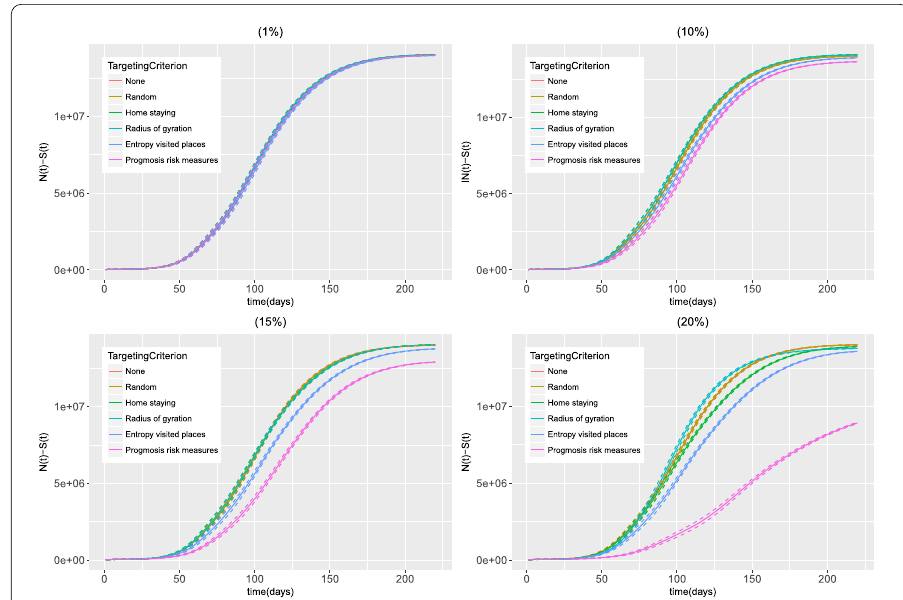
Figure 4 Performance of individual-level isolation based on different spatial indexes for determining targeted individuals ( none : no counter measure, random : a portion of individuals isolated randomly, radiusofgyration : a portion of individuals isolated based on the value of their radius of gyration, entropyvisitedplaces: a portion of individuals isolated based on the value of the entropy of visited sub-prefectures, homestaying : a portion of individuals isolated based on the value of the percentage of time spent at home, Progmosisrisk : a portion of individuals isolated based on the value of the Progmosis risk model). The percentage of isolated individuals is set to 1% (top-left), 10%, 15% and 20% (bottom-right) of the whole population. Solid lines represent the average number of infections over the time, dashed lines represent the 95% confidence interval